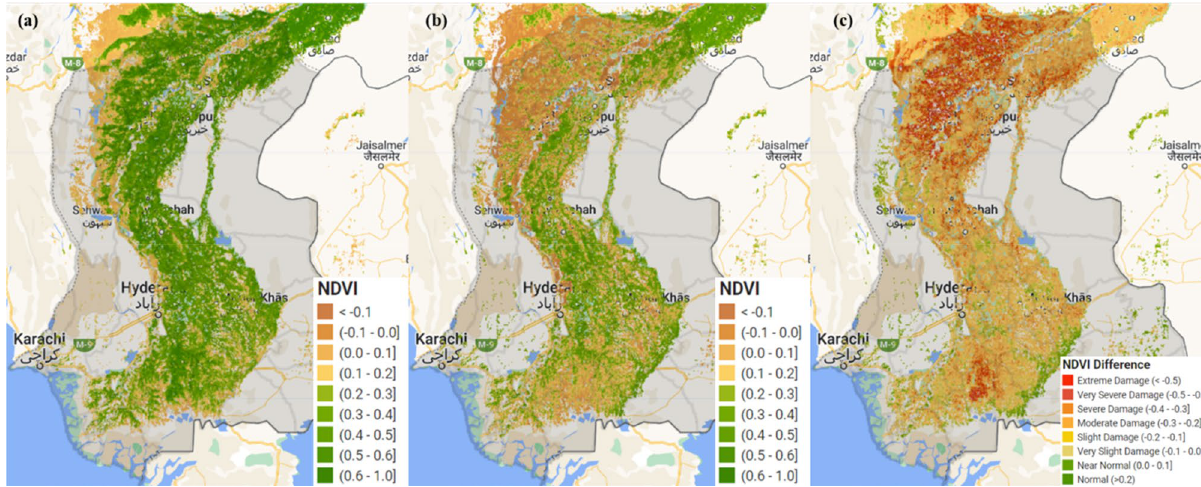
Figure 7. Loss and damage to cropland based on the NDVI difference ( a ) control or reference composite image, ( b ) composite image acquired during a flood event, ( c ) NDVI difference image indicating loss and damage to cropland. All the images were masked to cropland pixels. the maps were produced using the Google Earth Engine (https:// earth engine. google.